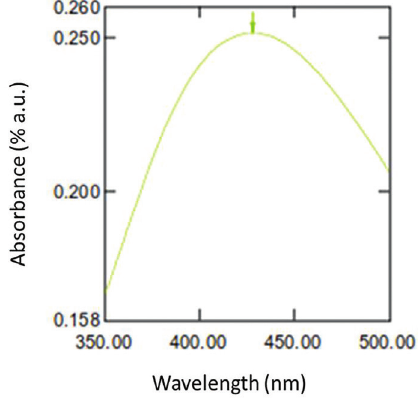
Figure 3: Zeta potential distribution of the synthesized Ag NPs using E. coli (a), S. aureus (b), B. cereus (c) and S. e. subsp. enterica (d)